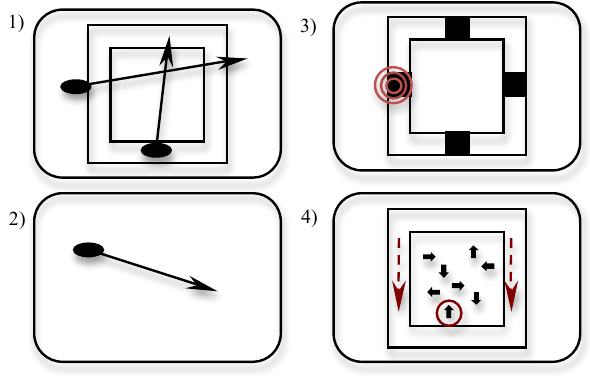
Figure 6: 1) Long and short gestures, 2) Without GDOs, and 3) Dwell GDO Interface, 4) Task targets. The small black arrows descend the screen; the bottommost arrow is the target the user must